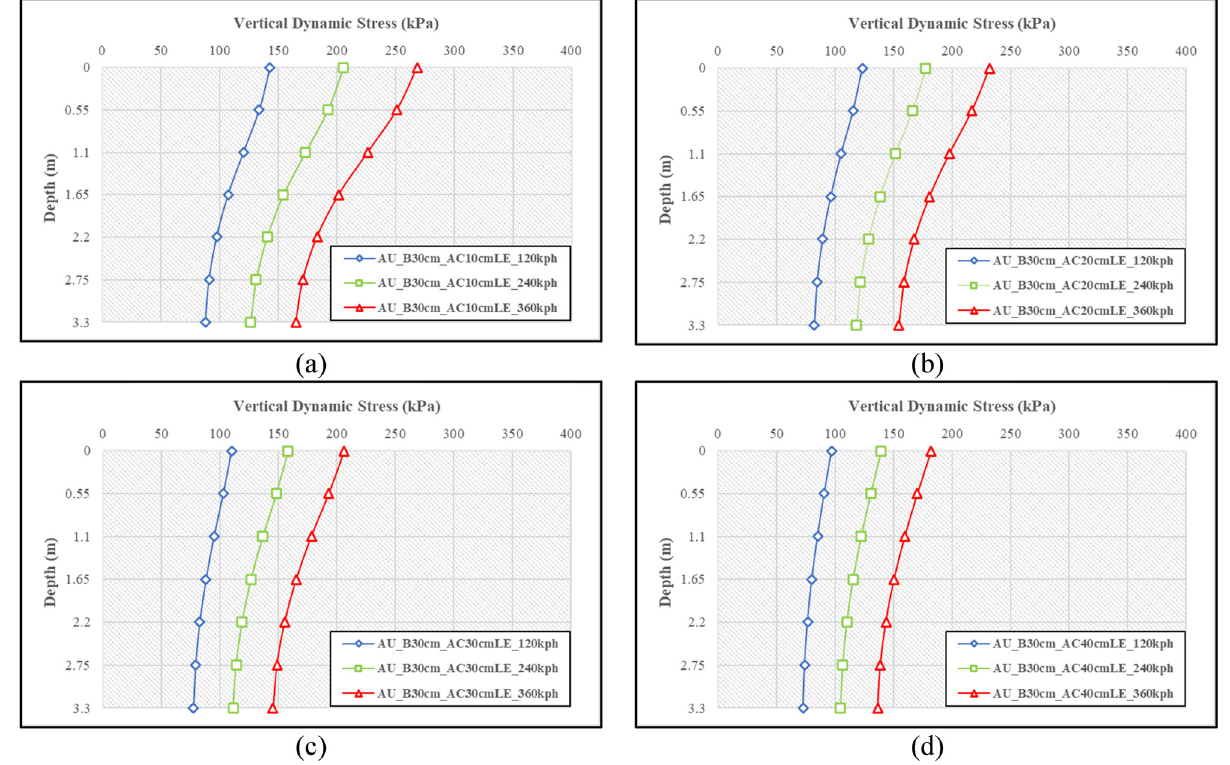
Figure 7: Vertical compressive stress curve in subgrade layer of asphaltic underlayment track under train speed of 120, 240, and 360 kph: ( a ) AC layer 10 cm, ( b ) AC layer 20 cm, ( c ) AC layer 30 cm, and ( d ) AC layer 40